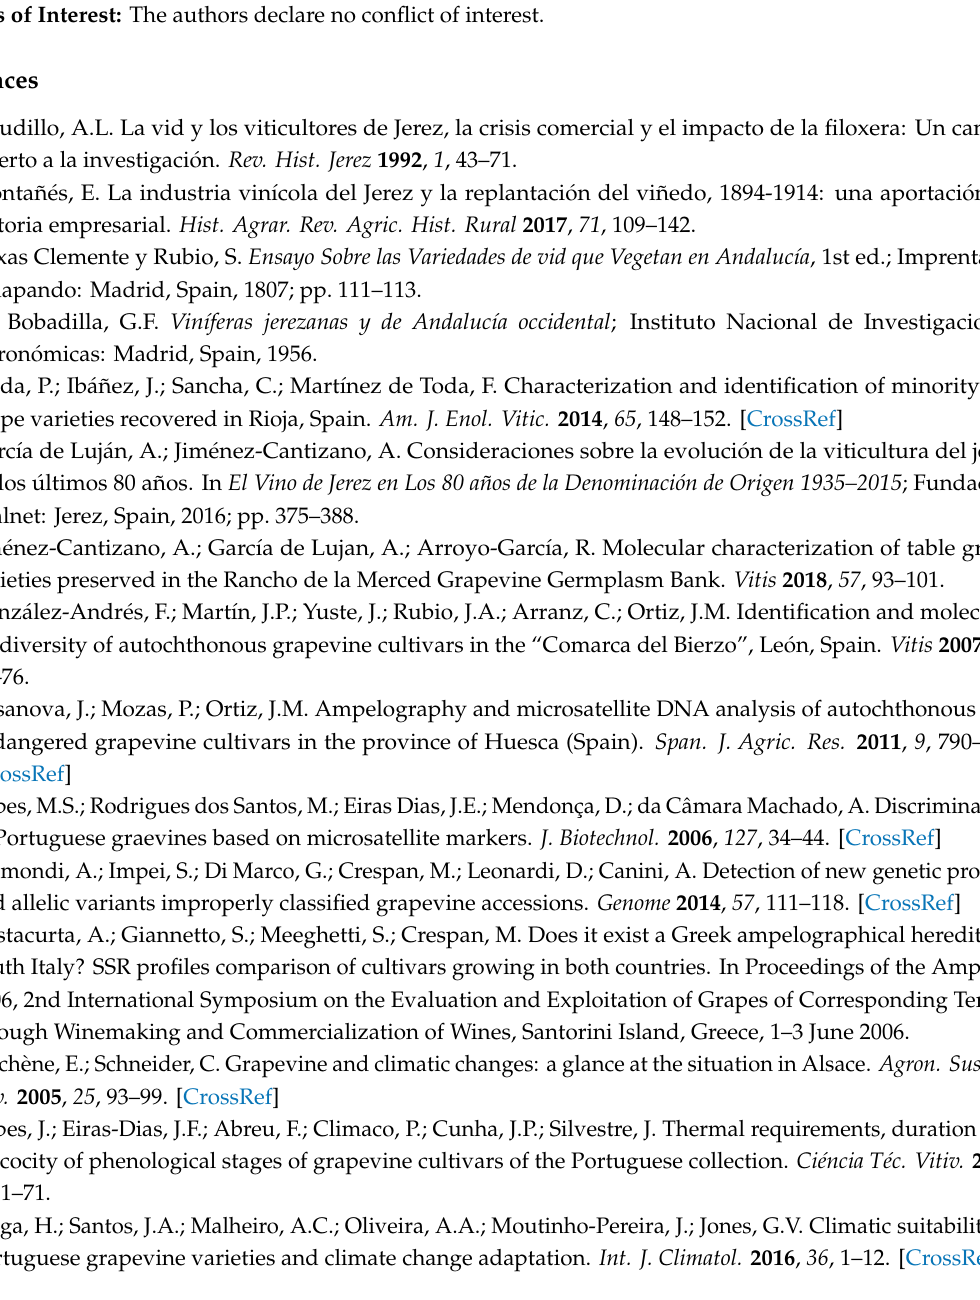
Figure S1: (a) Temperature ( ◦ C) (T_max, T_min, T_avg), (b) humidity (%) (H_max, H_min, H_avg), and (c) radiation (W / m 2 ) and rainfall (L / m 2 ) among July and September 2016. Figure S2: (a) Temperature ( ◦ C) (T_max, T_min, T_avg), (b) humidity (%) (H_max, H_min, H_avg), and (c) radiation (W / m 2 ) and rainfall (L / m 2 )